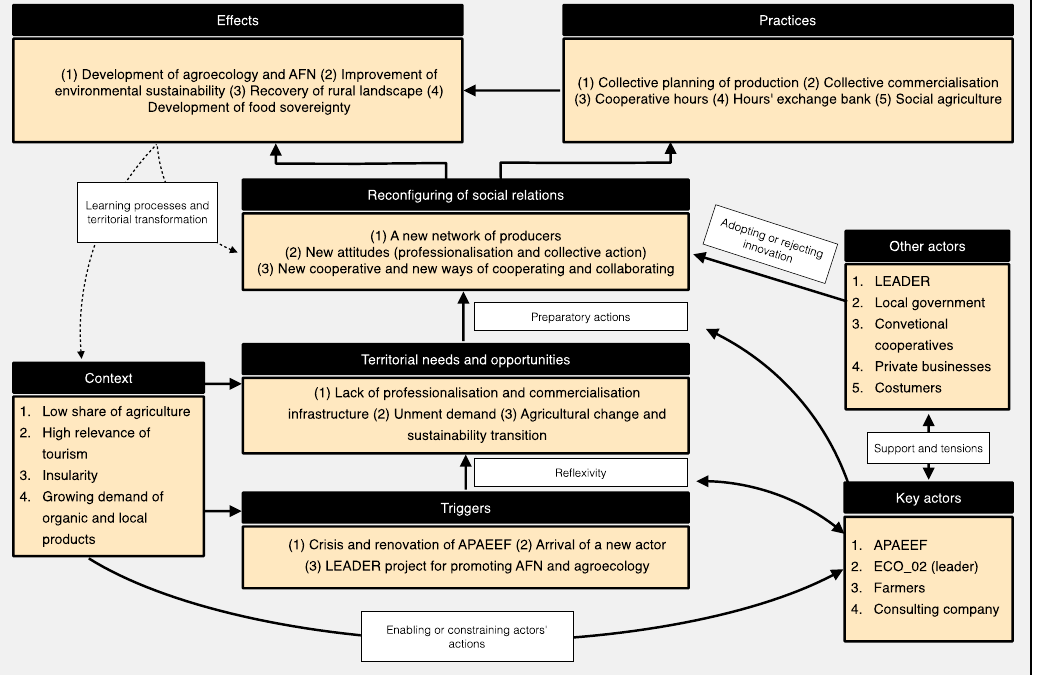
Figure 4. SI process in Ecofeixes. Own elaboration based on the research results.